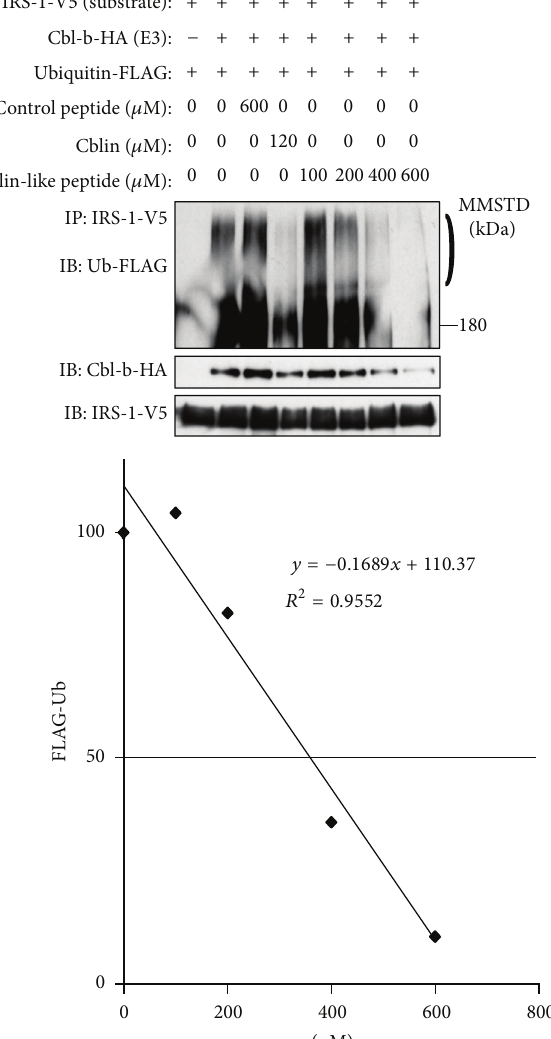
Figure 3: Inhibitory effect of Cblin-like synthetic peptide on Cbl- b-mediated degradation and ubiquitination of IRS-1. HEK293 cells were transfected with mock vector/pCEFL-Cbl-b-HA, pcDNA3.1- rat IRS-1-V5, and pcDNA3-FLAG-Ubiquitin and then treated with 100nM epoxomicin at 2 hours before treatment with each peptide at the indicated concentrations. One hour later, these cells were treated with 10ng/mL IGF-1 for 1 hour. Immunoprecipitates (IP) from whole cell lysates incubated with an anti-IRS-1 antibody were subjected to immunoblot (IB) analysis for the indicated proteins. The densitometric measurement of FLAG-Ub (the area indicated by right parenthesis) was performed with an ImageJ software (National Institute for Health). MMSTD: molecular mass standards. Representative findings of three experiments with matching results.